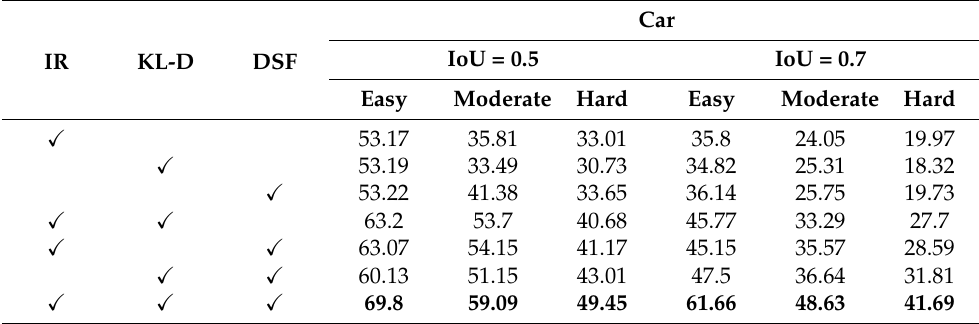
Table 7. Ablation study for IR-DC Net (The (cid:88) indicates that the corresponding component is included in the